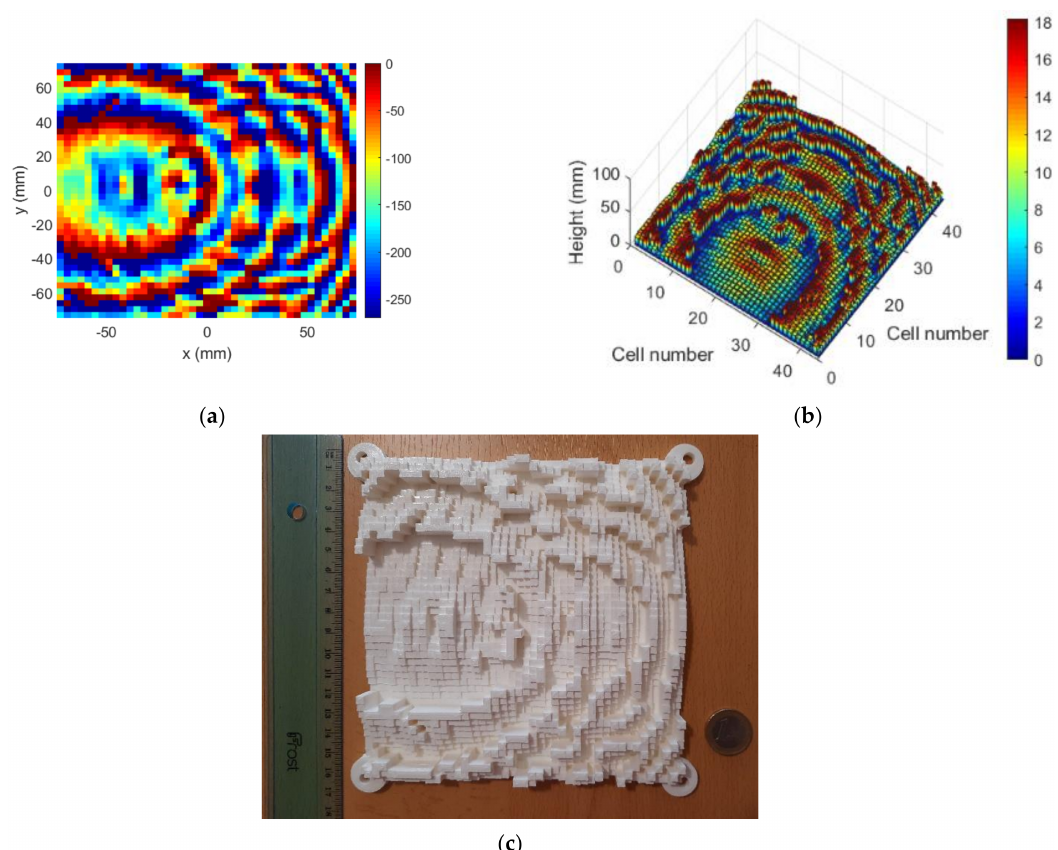
Figure 17. Case 2, dielectric TA: ( a ) required phase (0 ◦ –270 ◦ ); ( b ) TA design; ( c ) fabricated TA.